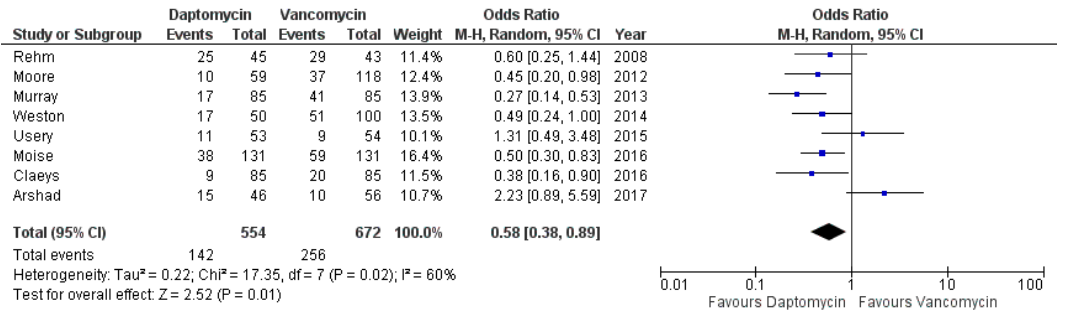
Figure 3. Forest plot depicting the odds ratio of clinical failure of patients receiving daptomycin vs. vancomycin.